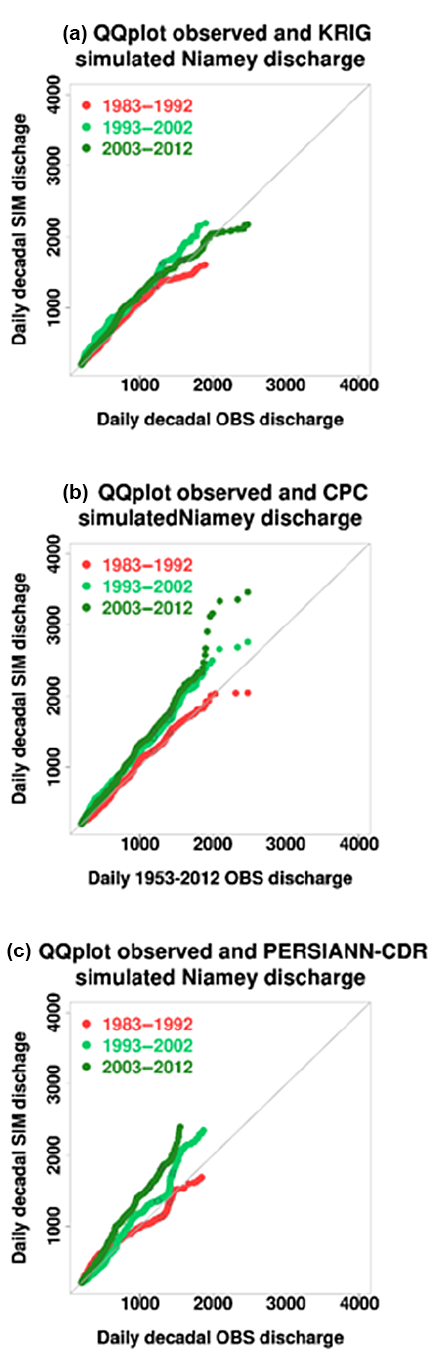
Figure 7. Quantile–quantile plot (Q–Qplot) of the red flood period distribution of daily discharge of each decade between 1983 and 2012. The x axis is for observations and the y axis for the simula- tions.